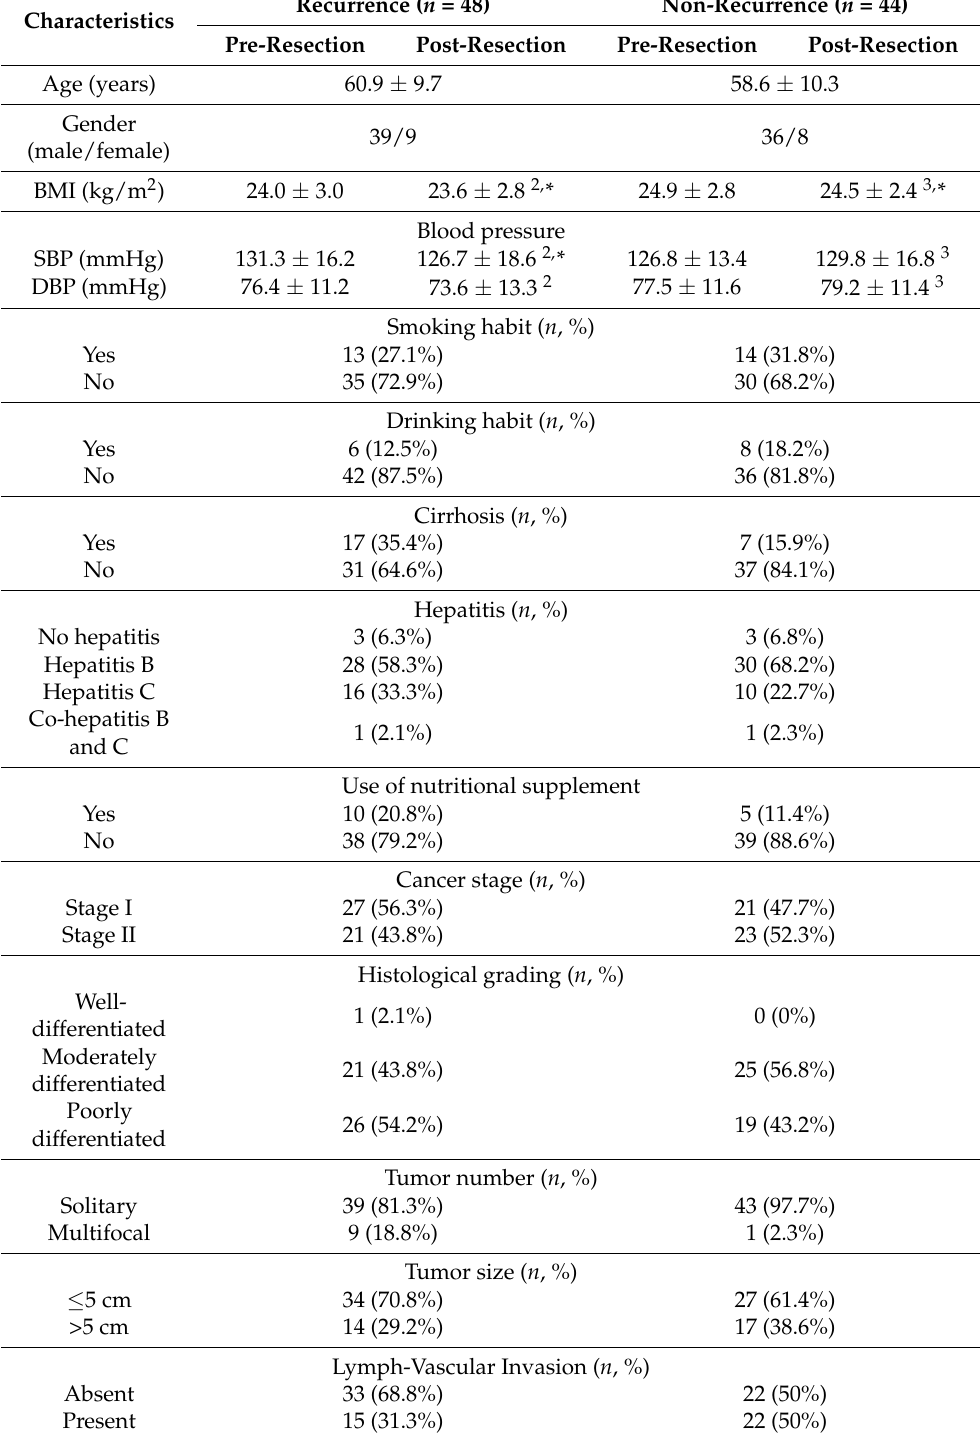
Table 1. Characteristics of patients with recurrent and non-recurrent hepatocellular carcinoma at pre-resection and post-resection 1